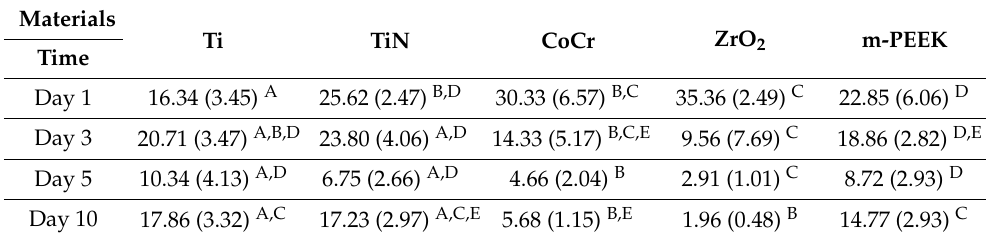
Table 4. The mean and standard deviation values of HGKC cell cytotoxicity percentage at days 1, 3, 5, and 10. Values with the same superscript letters represents a non-significant difference (Tukey’s post hoc ( p > 0.05)) between the investigated materials at each time